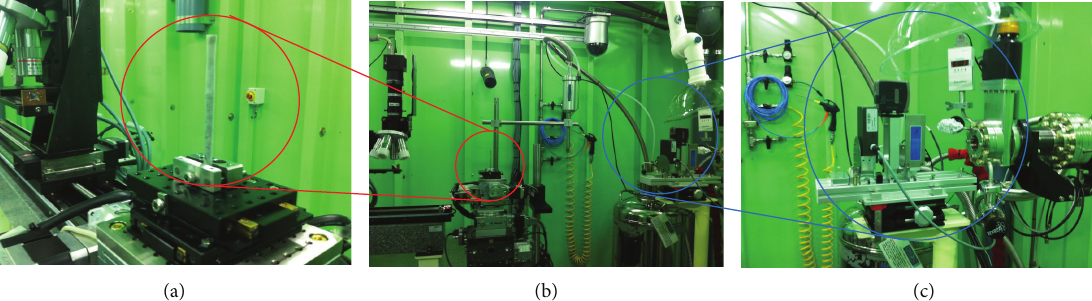
Figure 2: Specimen and CT image equipment using high-energy X-ray (PAL): (a) specimen setting, (b) micro-CT equipment, and (c) X-ray injection part.